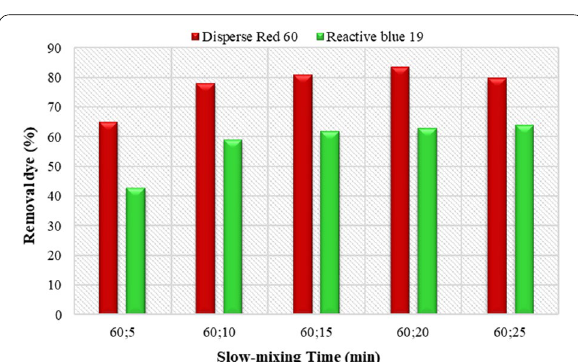
Fig. 8 The effect of Temperature on the efficiency of removal of Disperse red 60 and Reactive blue 19 dyes. (Initial pH 11, Alcea rosea = concentration 200 mg/L and initial dye concentration 40 mg/L = = for Disperse experiments; initial pH 11, concentration 250 mg/L = = and initial dye concentration 20 mg/L for Reactive experiments; = rapid-mixing speed 180 rpm; rapid-mixing time 3 min; = = slow-mixing speed 10 rpm; slow-mixing time 15 min; = = Sedimentation time 60 =